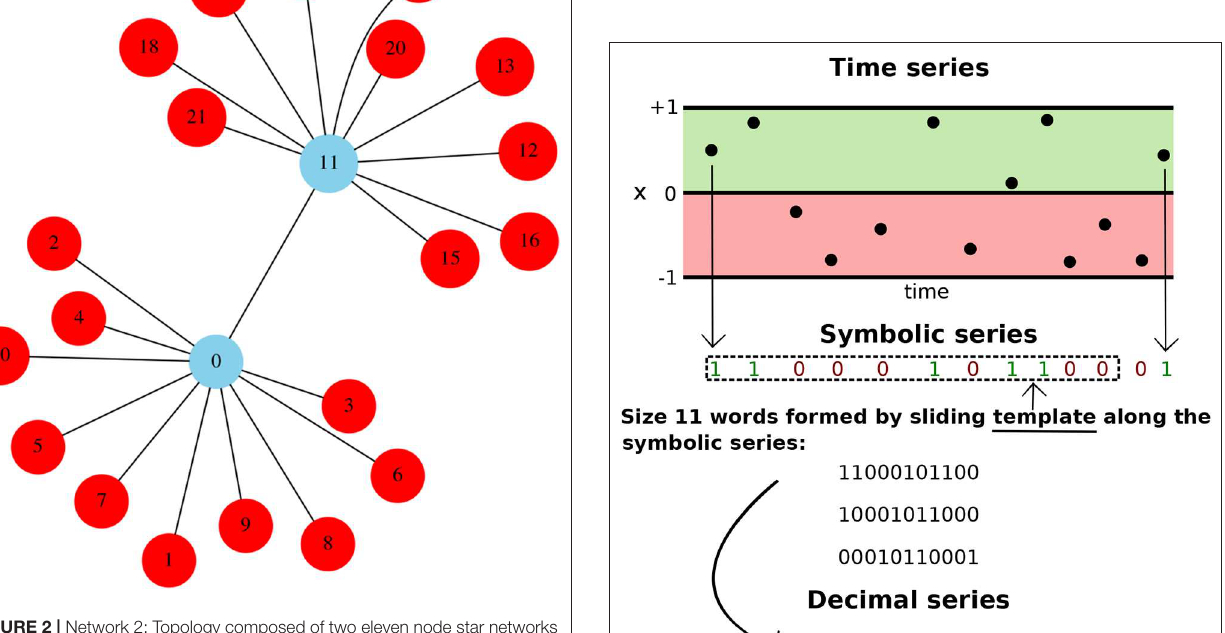
FIGURE 2 | Network 2: Topology composed of two eleven node star networks whose hubs are connected. The star on the lower left, composed of nodes 0 to 10 is referred as Star 1 (S1), the star on the upper right, composed of nodes 11 to 21 is referred to as Star 2 (S2). FIGURE 3 | Symbolical and decimal characterization of a time